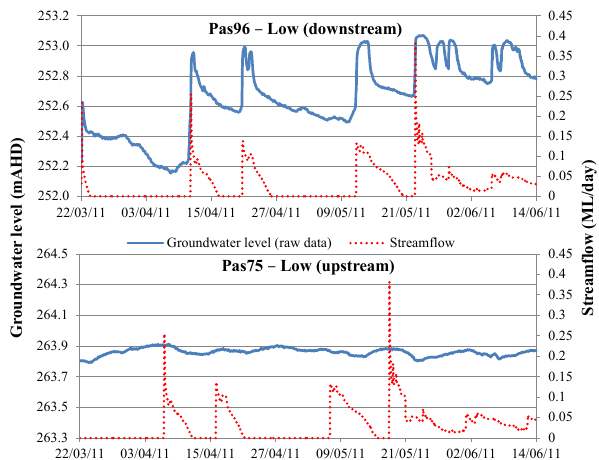
Figure 6. Pasture stream hydrographs (Dwyer’s Creek) and bores hydrographs from the bottom of the catchment (Pas96) and midway up the catchment